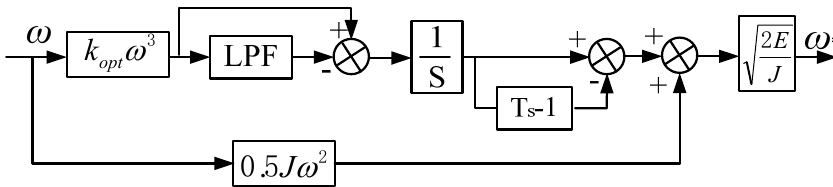
Figure 5. Rotor inertial power smoothing control by adopting the low-pass filter.